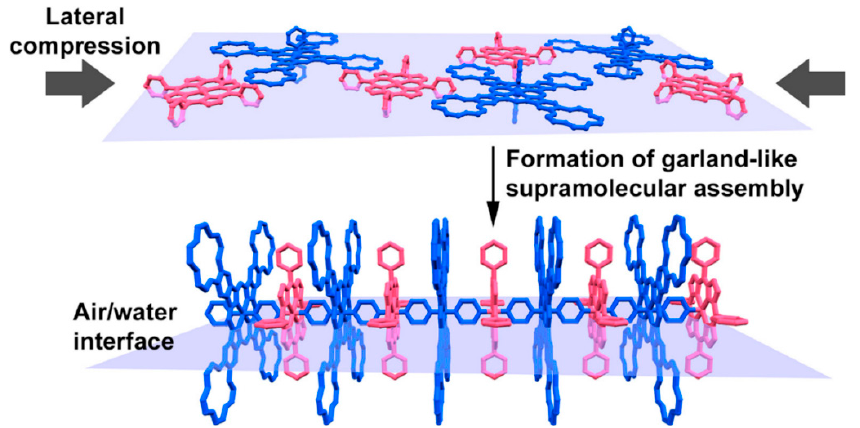
Figure 9. A cartoon illustrating the proposed formation of a supramolecular assembly of NiTPP and CRPcRu(pyz) 2 in the mixed Langmuir monolayer upon its lateral compression.